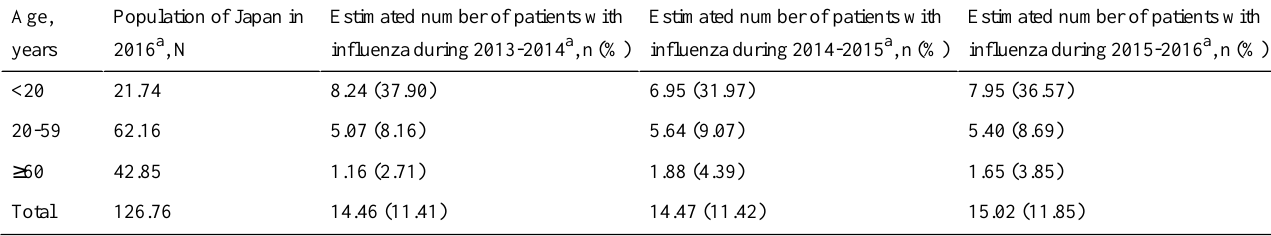
Table 2. Estimated influenza morbidity ratios for the general Japanese population according to age, based on Japanese Government reports. All data were drawn from reports of the Japanese Ministry of Internal Affairs and Communications and the Ministry of Health, Labour and Welfare.